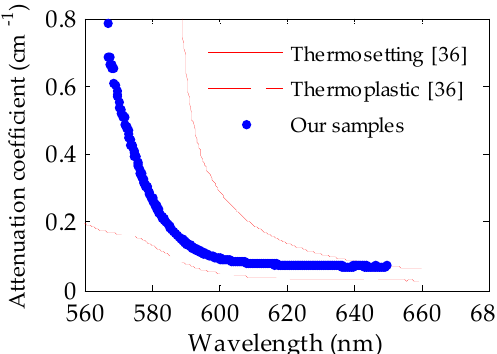
Figure 8. Evolution of ( a ) the first moment ( N 1 ) and of ( b ) the square root of the second moment ( as a function of the excitation wavelength for our POFs doped with rhodamine B at 10 ◦ C. The fiber was pumped at 520 nm with an irradiance of 22 nJ/cm 2 . The z of the point of the fiber closest to the detector is normalized to 0.